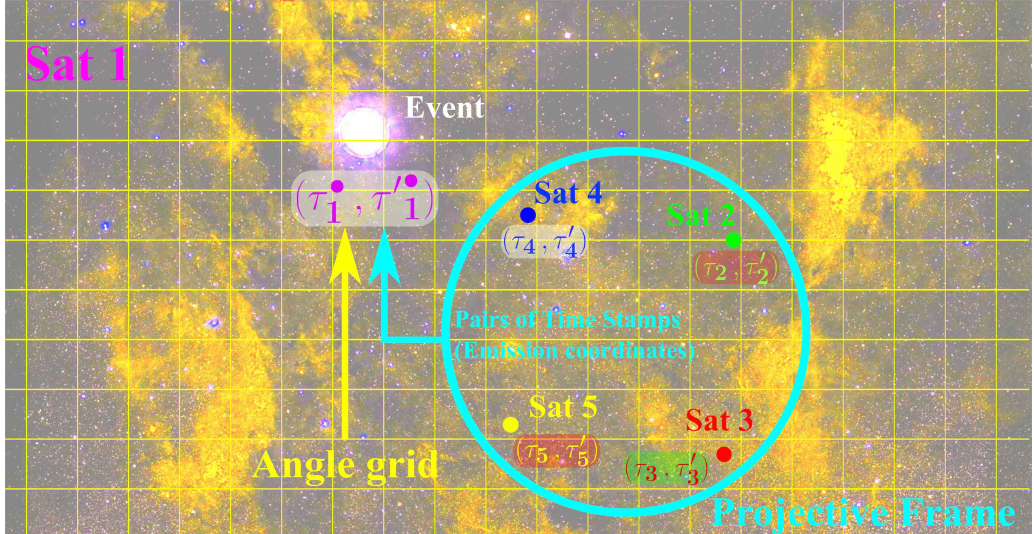
Figure 2. “Retina view” of Satellite (Sat) 1. The yellow lines represent the angle grid for longitude and latitude on the satellite 1 retina. The four green, blue, red, and yellow points constitute the projective frame. Each point is associated with one of the four other satellites of the RLS and to each is ascribed a pair of time stamps ( τ , τ (cid:48) )